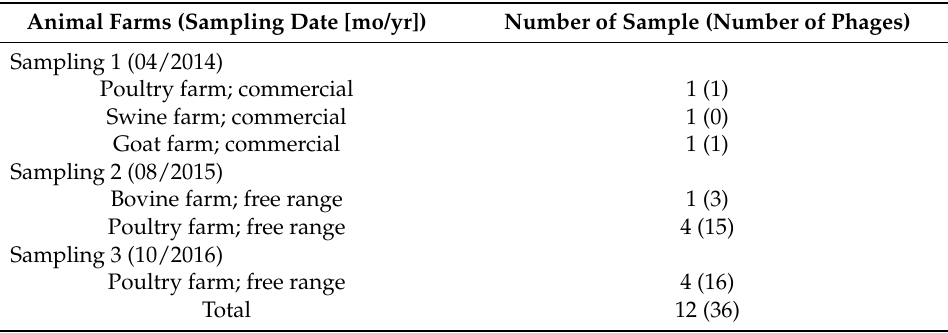
Table 2. Recovery of Salmonella phages from various animal farms in Thailand.